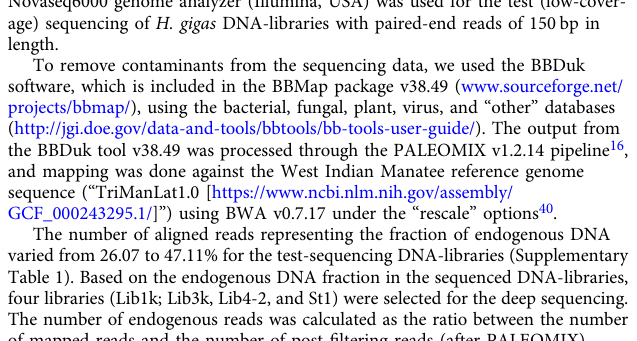
Table 1). Based on the endogenous DNA fraction in the sequenced DNA-libraries, four libraries (Lib1k; Lib3k, Lib4-2, and St1) were selected for the deep sequencing. The number of endogenous reads was calculated as the ratio between the number of mapped reads and the number of post- fi ltering reads (after PALEOMIX). Deep DNA sequencing and PALEOMIX analysis . DNA-libraries with a higher content of endogenous DNA (Supplementary Table 2) were used for deep sequencing. For the deep DNA sequencing, we used an equimolar DNA-library pool. The S2 fl owcell of the Illumina Novaseq6000 genome analyzer